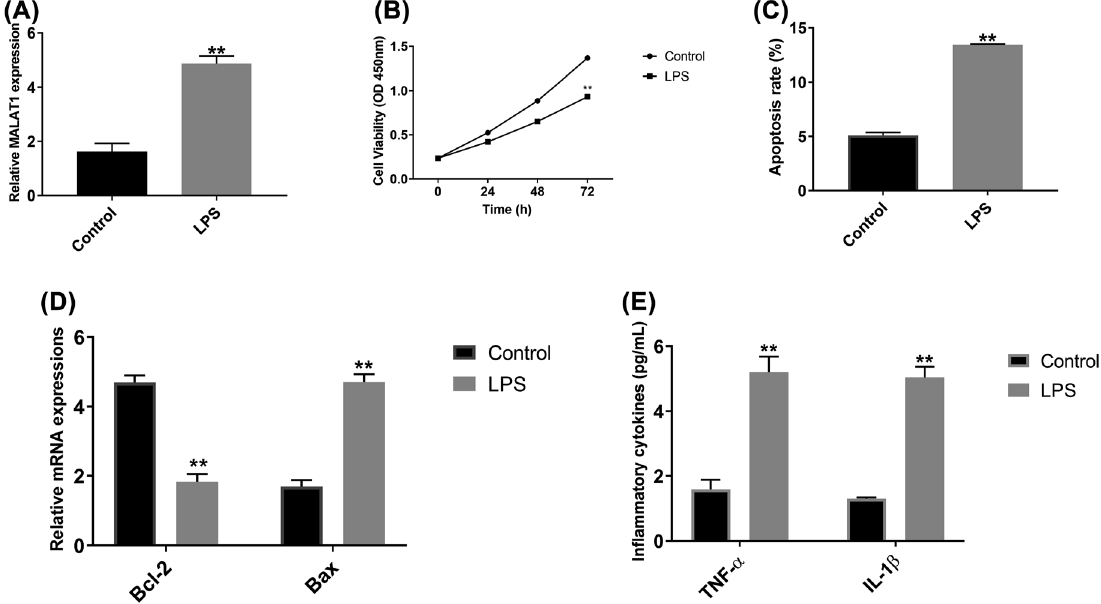
Figure 1: Long non-coding RNA metastasis-associated lung adenocarcinoma transcript 1 (lncRNA MALAT1) was upregulated in lipopolysac- charide (LPS) stimulated periodontal ligament cells (PDLCs).